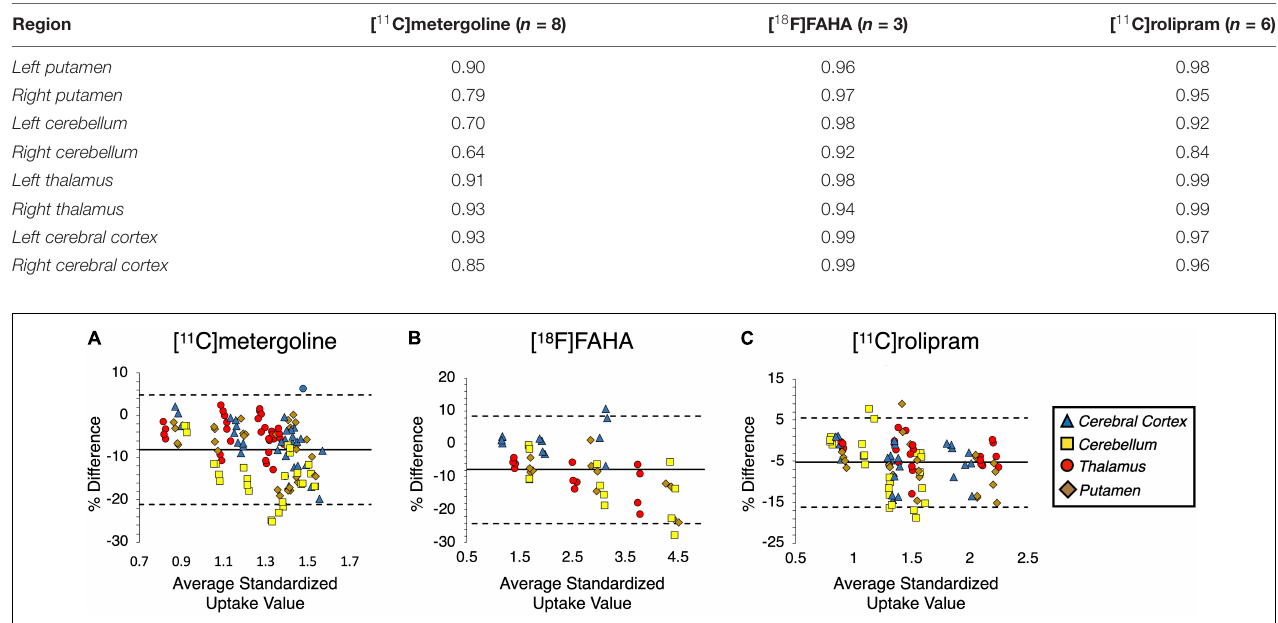
TABLE 4 | Atlas evaluation on PET images by the intraclass correlation coefficient between the atlas and manual segmentation.